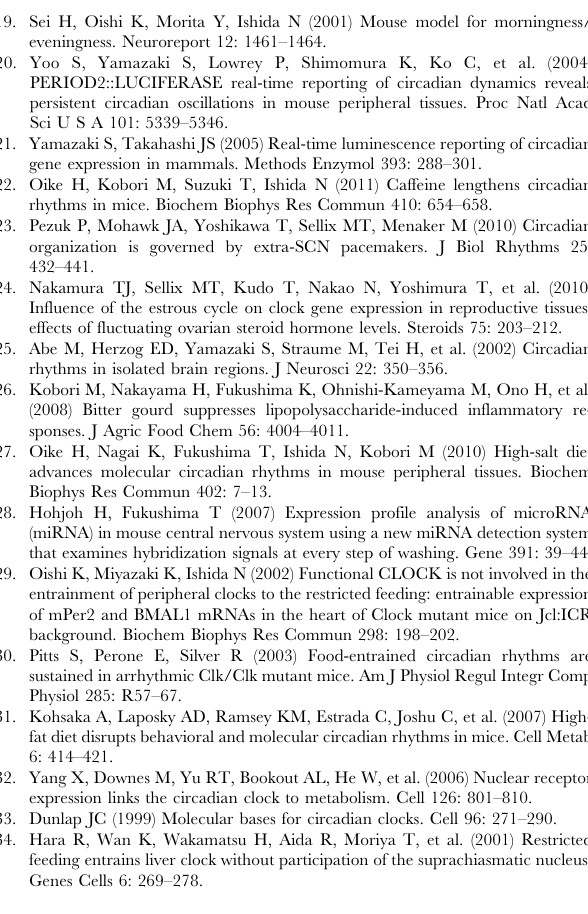
Figure S1 Representative data of temporal food con- sumption immediately before sampling in experiment shown Figure 1. Bars show amount of food consumed during